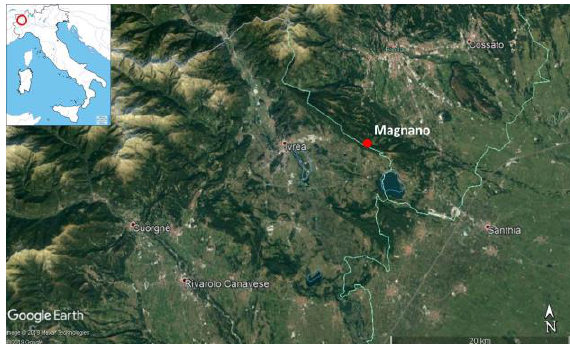
Figure 1. Position of Magnano on the outer ridge of the Serra d’Ivrea, in Piedmont (after Google Earth, modified).